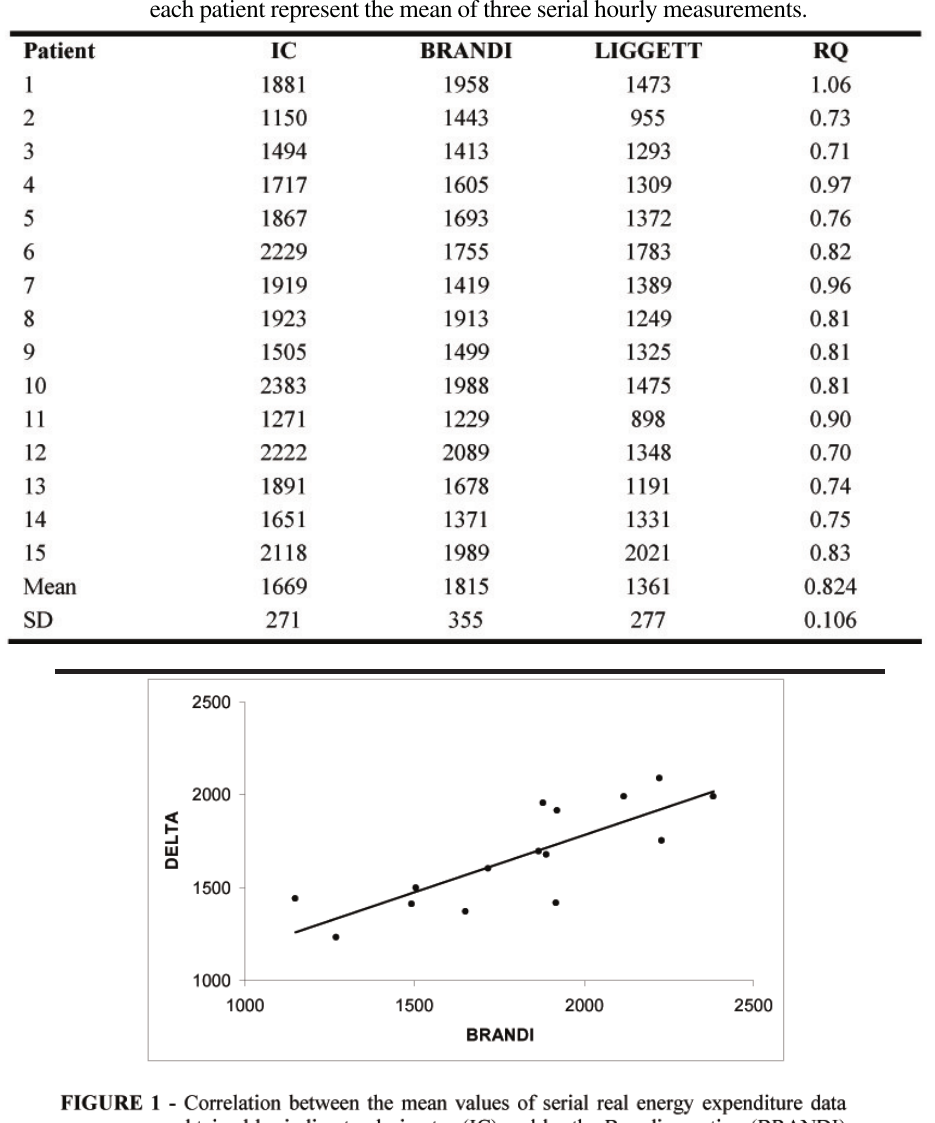
Real energy expenditure (REE in kcal.dia -1 ), obtained by indirect calorimetry (IC) and by the Brandi (REE = VO x 6.996) and Liggett (REE = CO x [96.54 x Hb x (SaO 2 – SvO )]) equations. The VO (mL.min -1 ) and respiratory quotient (RQ) values for 2 2 each patient represent the mean of three serial hourly